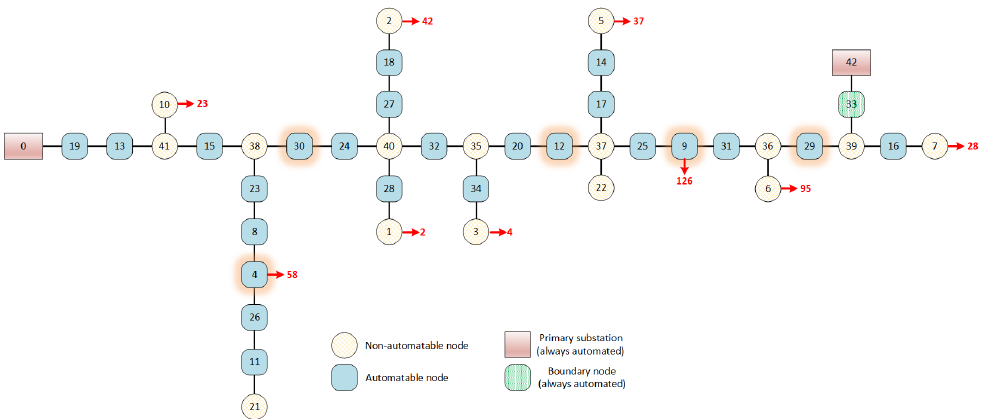
Figure 7. Optimal IEDs position provided by IED-OLP-ILP2. To better highlight the differences between the IED-OLP-ILP1 and IED-OLP-ILP2 solutions, we reported, in Table 4, the IEDs selected in the respective optimal solutions (denoted in the following with z and w , respectively). Table 4. Comparison of the IEDs used in the optimal solution considering the two objective functions.